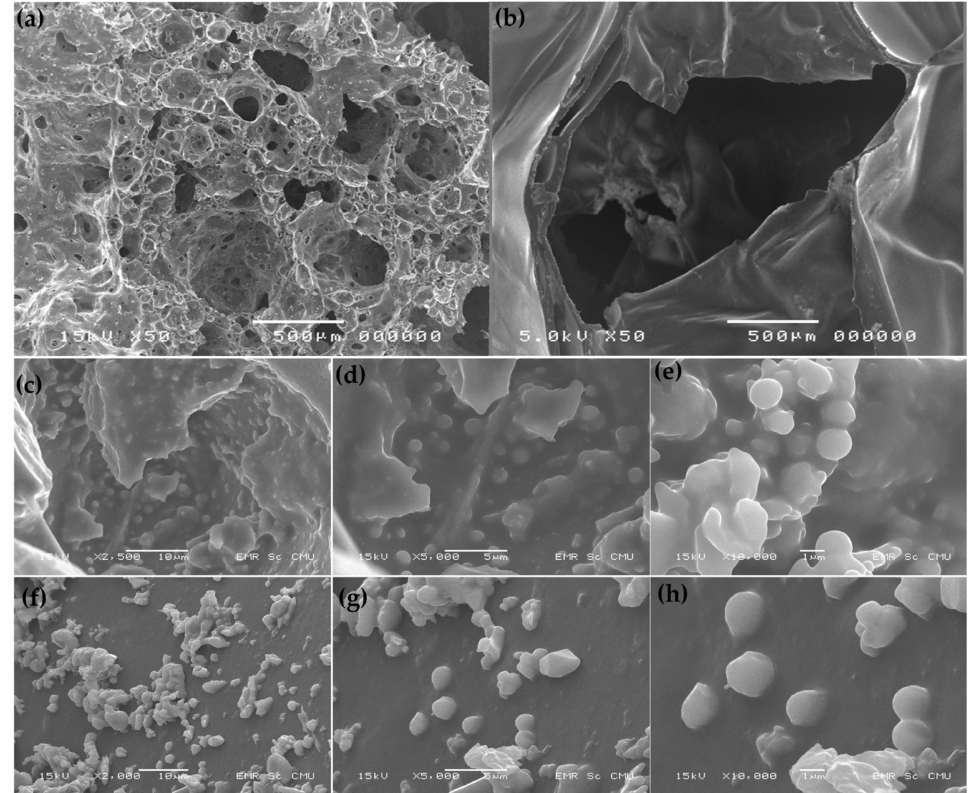
Figure 2. SEM images of packing materials ( a ) PG, ( b ) PUF, and immobilized P. versutus CM1 cells on the ( c – e ) PG and ( f – h ) PUF after 3 days of